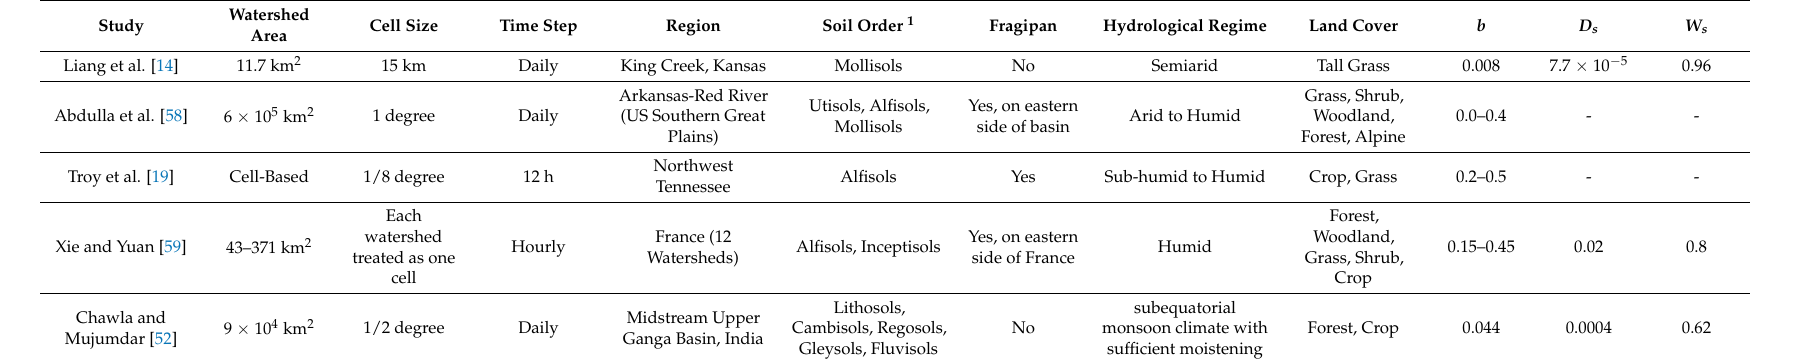
Table 2. Physical ranges for calibration parameters adopted in past